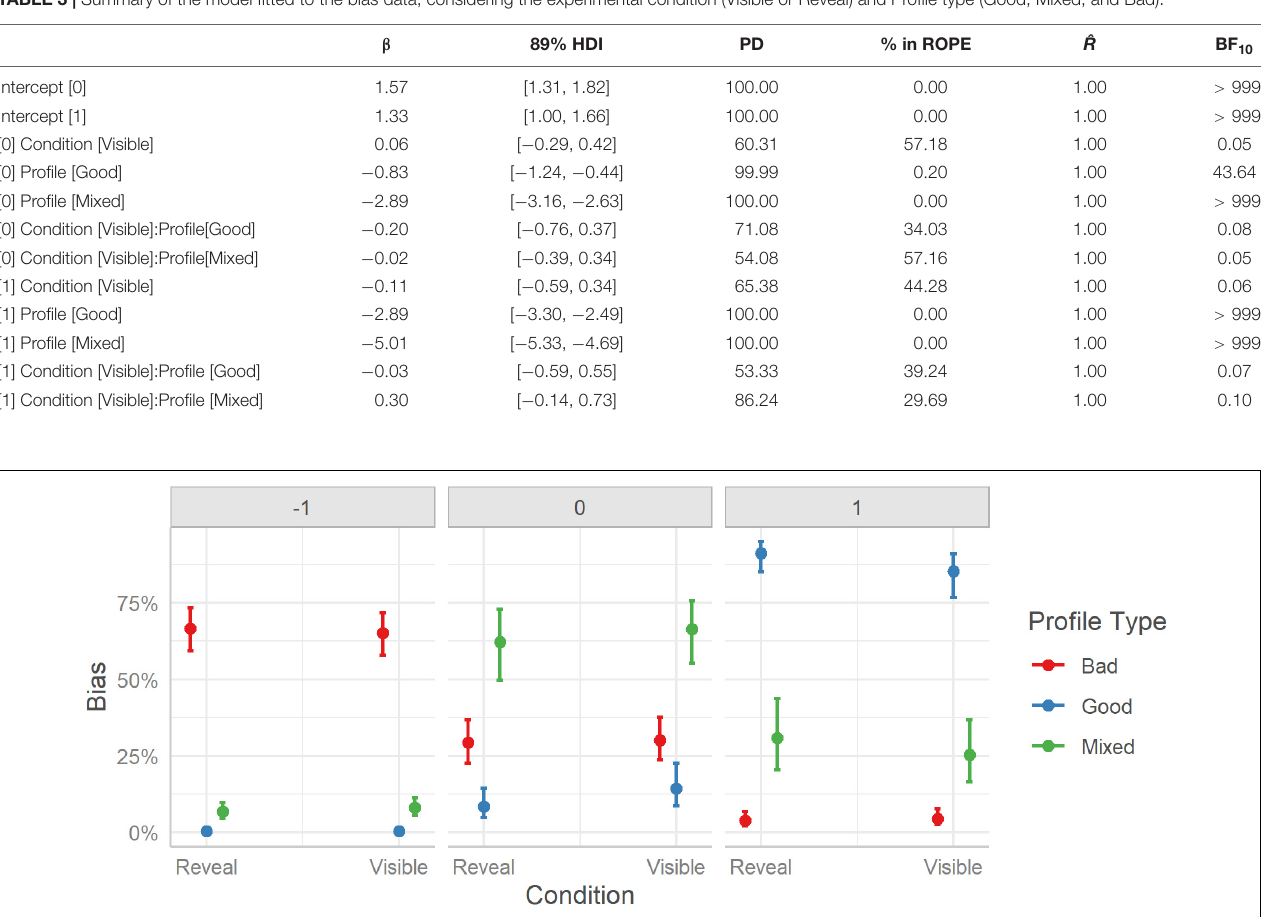
FIGURE 4 | User response bias to rating the profiles between the two experimental conditions (Reveal and Visible) split over the three Profile conditions (Bad, Mixed, and Good). Error bars indicate 95% credible intervals.